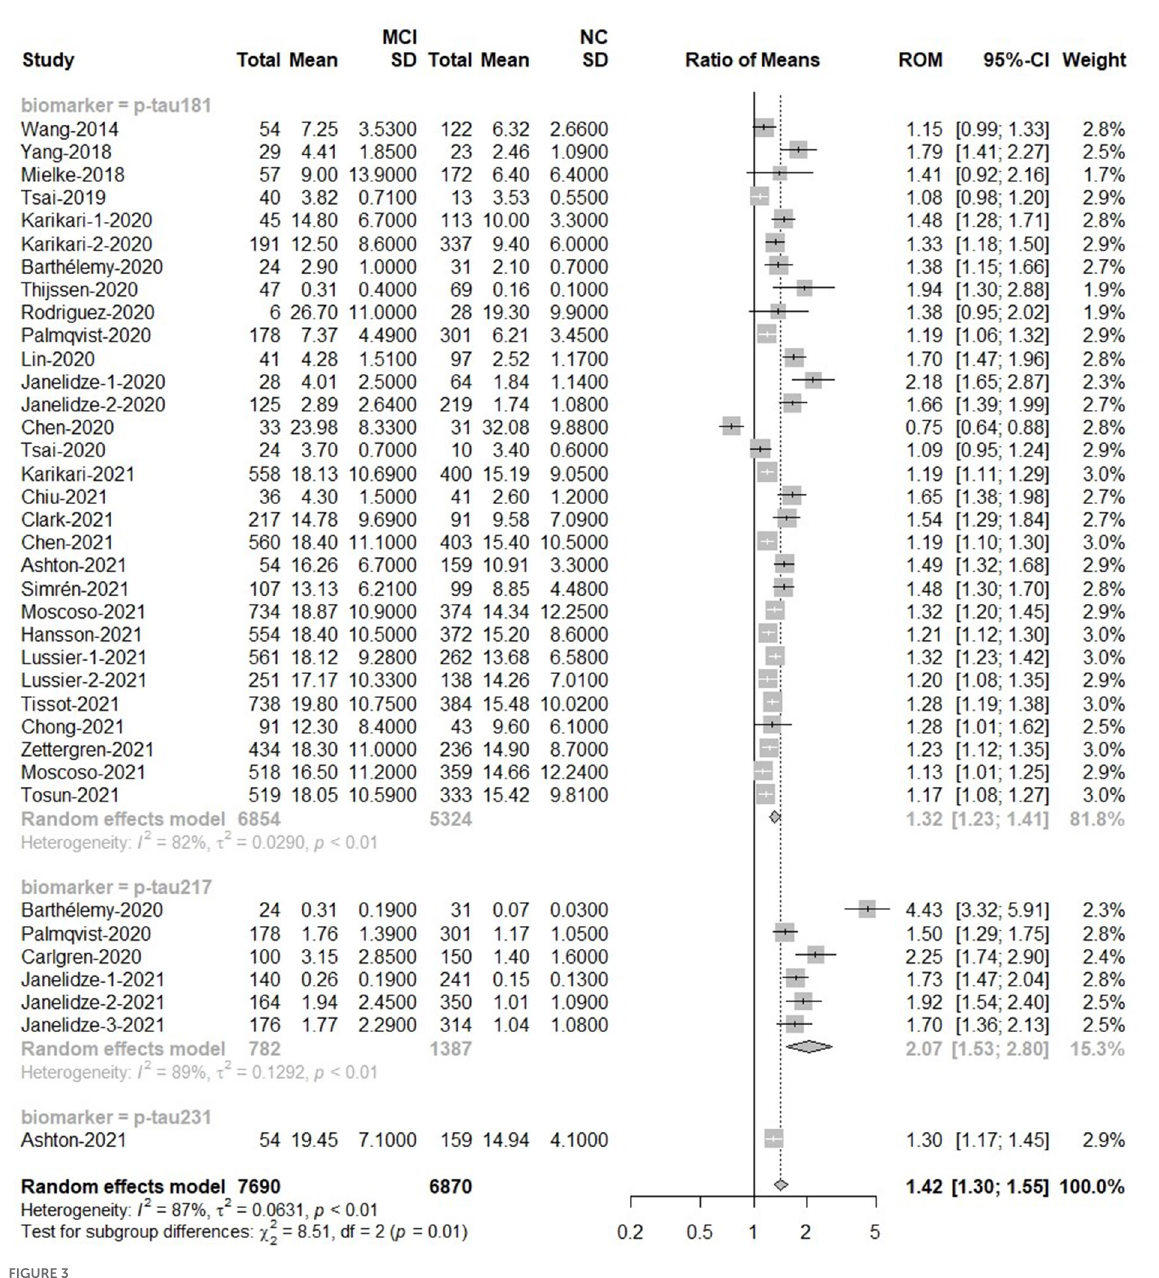
For the t-tau biomarker, the overall results showed t-tau concentration in MCI was higher than that in normal people [Ratio 1.36, 95%CI (1.12, 1.63)]. The results showed = = no significant difference in the ELISA, Simoa, MS and MSD subgroups. Only IMR could detect this difference [Ratio 95%CI (1.58, 3.06); Supplementary Figure =